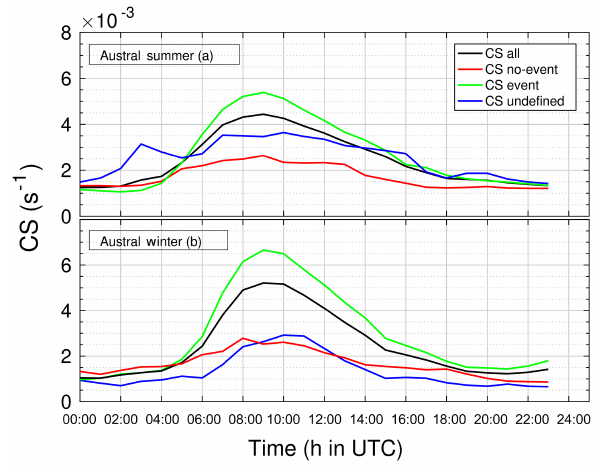
Figure A3. Diurnal variation in CS for (a) summer and (b)